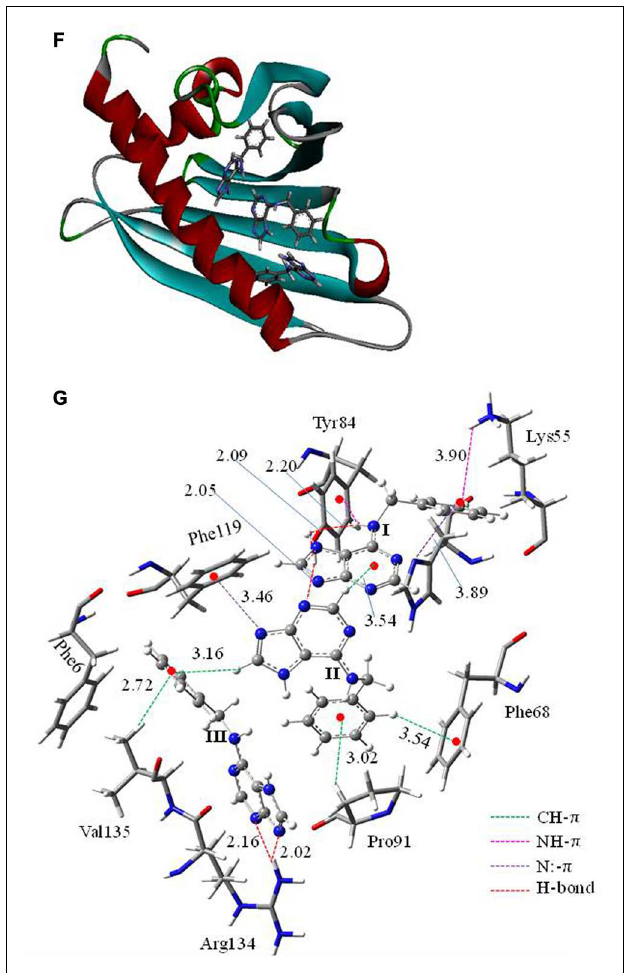
FIGURE 1 | (A) Shoot bud induction on regeneration medium on explants transformed with VA (vector alone, transgenic plants transformed with pCAMBIA1301) and JcPR-10a gene. (B) Graph showing number of shoot buds induced on regeneration medium after 30 days of transformation. Data represent the mean ± SE of three biological repeats. (C) Auxin and cytokinin concentration in regenerated shoot buds. Data represent the mean ± SE of three biological repeats. (D) Regeneration potential of WT and transgenic (L1, L4, and L6) on MS medium supplemented with 1 µ M BAP. (E) Graph showing number of shoot buds induced on MS medium supplemented with 1 µ M BAP after 20 days of subculture. Data represent the mean ± SE of three biological repeats. (F) The BAP molecules at the active site of the JcPR-10a protein. (G) Non-covalent interactions between the active site amino acid residues and BAPs. Amino acid residues are represented in tube fashion and BAP in ball and stick fashion. (gray: carbon; blue: nitrogen; white: hydrogen; red: oxygen).The interaction distance is given in ´